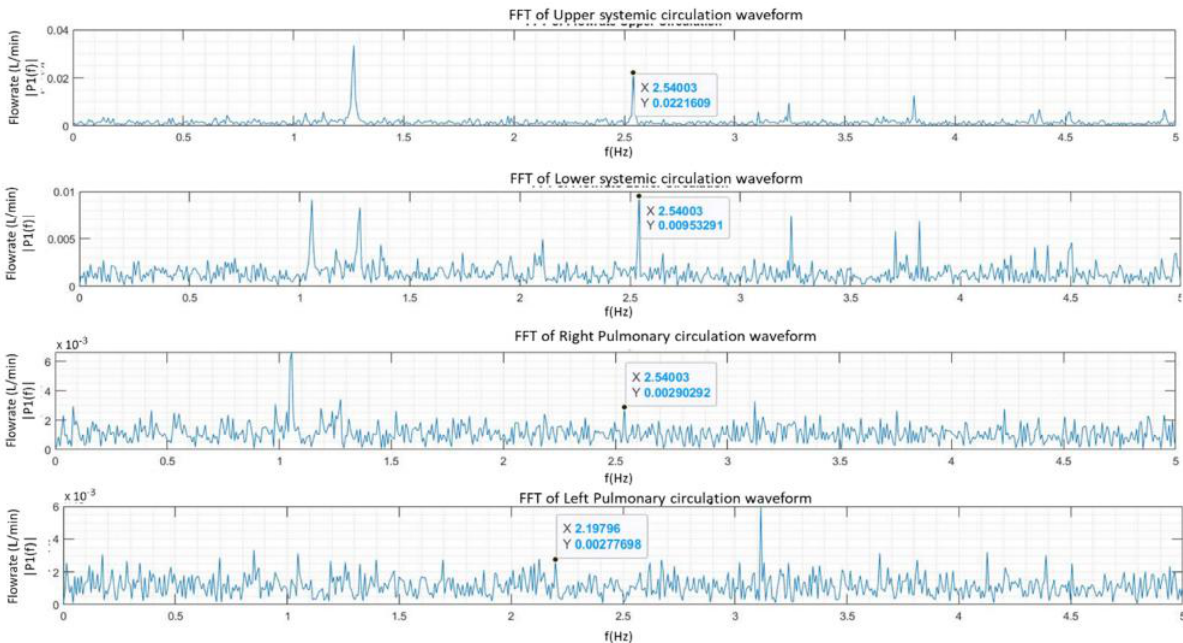
Figure 17. FFT on flow waveform for the 3 mm IJS experiment. Figure 17 . FFT on flow waveform for the 3 mm IJS experiment. Figure 17 . FFT on flow waveform for the 3 mm IJS experiment.